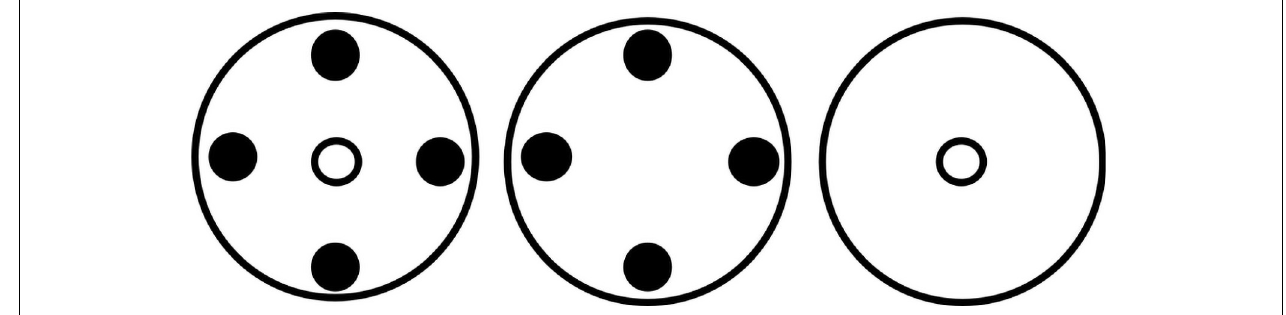
FIGURE 3 | Layout of plants in neighborhood design experiment. Large circles represent pots. Filled circles represent A. tuberculatus plants and open small circles represent maize plants.